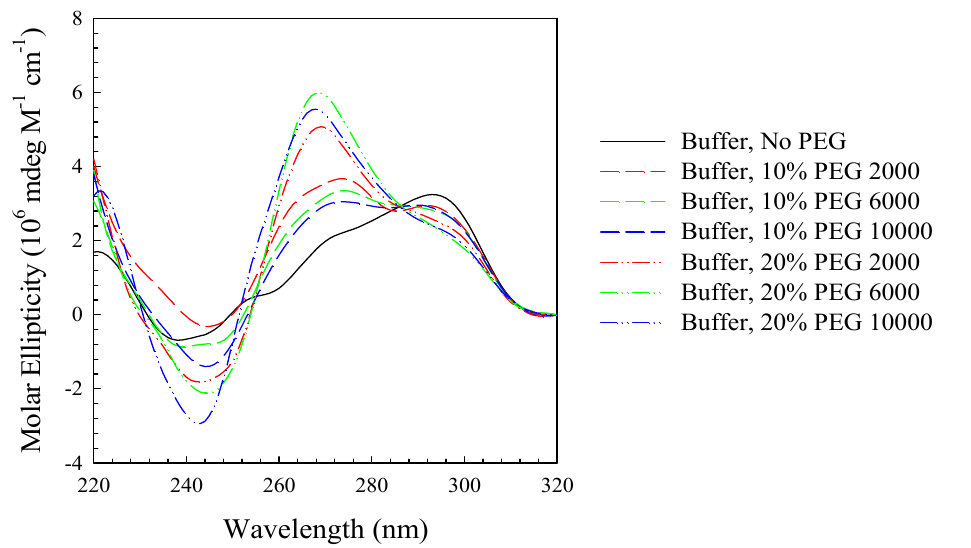
Figure 1. CD spectra at 25 °C in standard potassium phosphate buffer (115 mM K + ) of , in the absence (solid black line) or presence of 10% (dash) or 20% (dash-dot-dot) (TTAGGG) 4 PEG 2,000 (red), PEG 6,000 (green) or PEG 10,000